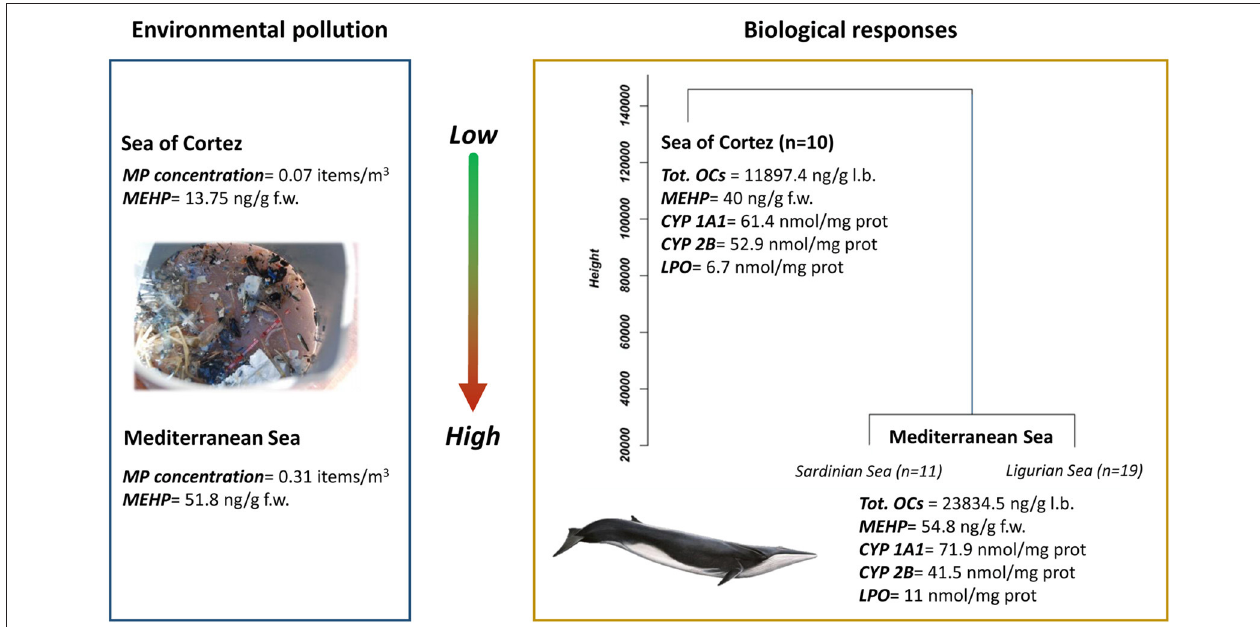
FIGURE 2 | Comparison between microplastic concentration and phthalates in zooplankton samples and the cluster dendrogram resulting from the analysis of biological parameters (mean values) measured on fin whale skin biopsies from the Sea of Cortez (Mexico) and Mediterranean Sea (Sardinian and Ligurian Sea). MP, microplastic; MEHP, mono-(2-ethylhexyl) phthalate; CYP1A1, cythocrome P450 1A1; CYP2B, cythocrome P450 2B; LPO, lipid peroxidation; OCs: organochlorine compounds (modified from Fossi et al.,